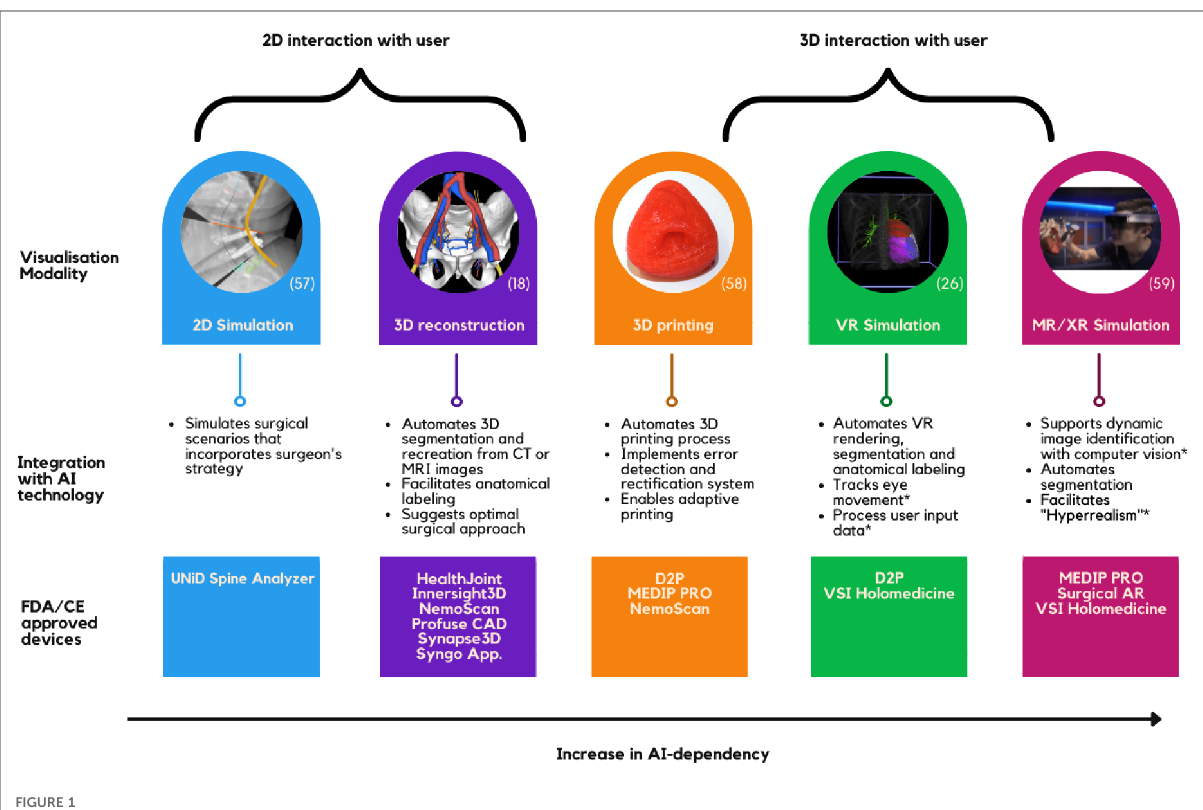
FIGURE 1 Summary of AI function in visualisation